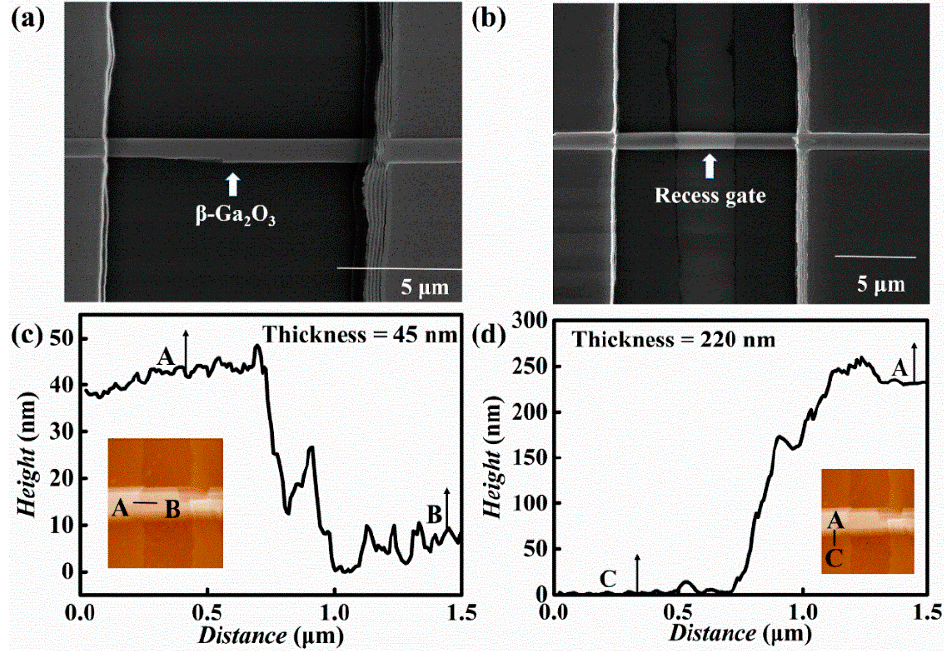
Figure 4. ( a ) SEM image of a β− Ga 2 O 3 thin film made of a FET structure using a Ti/Au electrode, ( b ) SEM image of the local thinning of a Ga 2 O 3 FET, ( c ) AFM height distribution of the local thinning and the Ga 2 O 3 ( d ) .